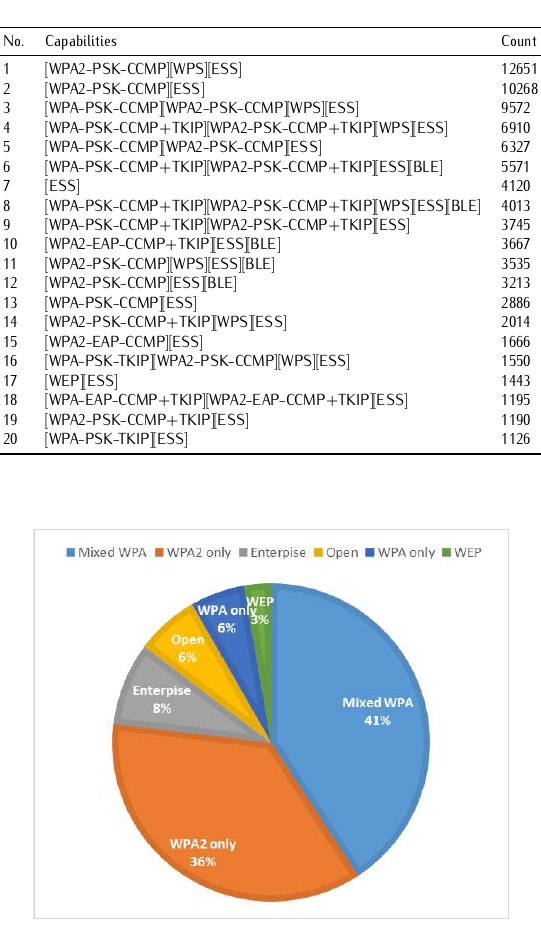
Figure 5. Analysis of Table 3 security